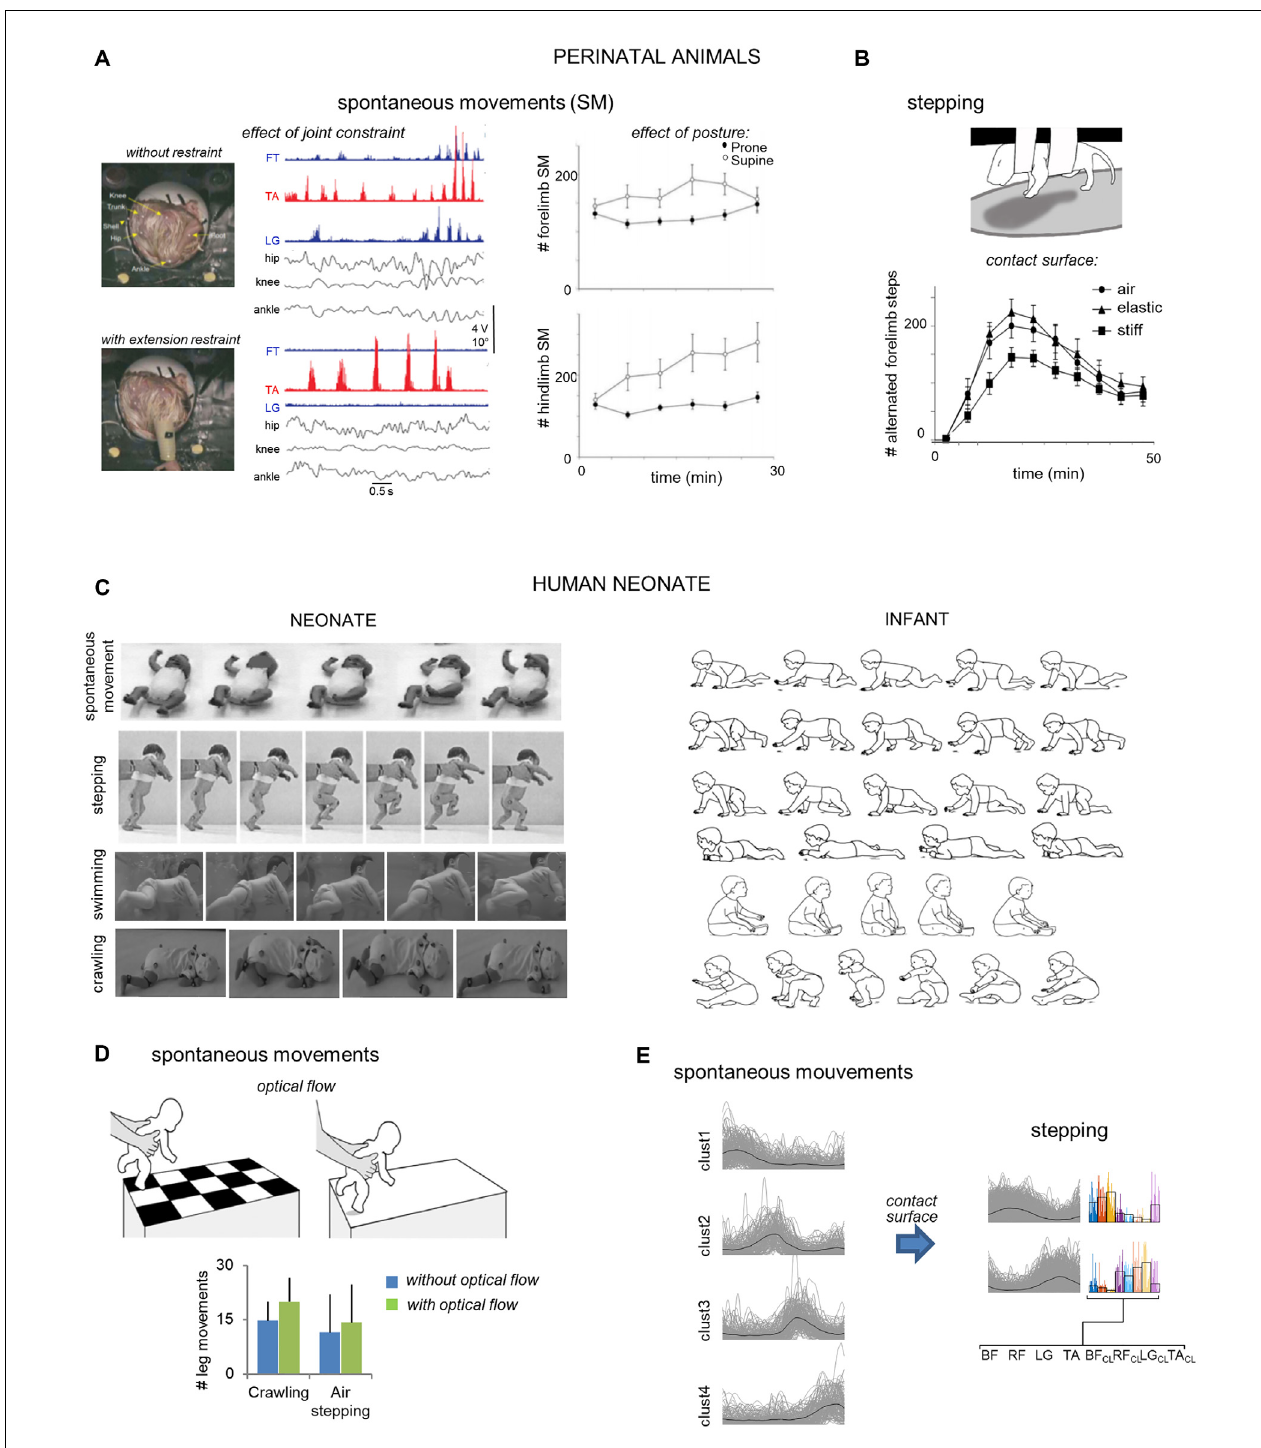
FIGURE 1 | Early responsiveness to sensory or environmental changes in animal (A,B) and human (C,D) neonates. (A) Left: effect of ankle extension restraint, imposed by a lightweight splint, on EMG activity in chicken embryos. During extension restraint, the ankle flexor (TA) was rhythmically active but bursts were longer in duration and larger in amplitude. Also, knee extensor (FT) and ankle extensor (LG) activity dropped out (adapted from Bradley et al., 2014). Right: a greater number of SMs of newborn rat pups in supine than in prone position (from Mendez-Gallardo et al., 2016). (B) A smaller number of alternated forelimbs steps induced by drug treatment (quipazine) on a stiff substrate as compared to an elastic or no substrate (adapted from Brumley et al., 2012). (C) Left: video frames with examples of